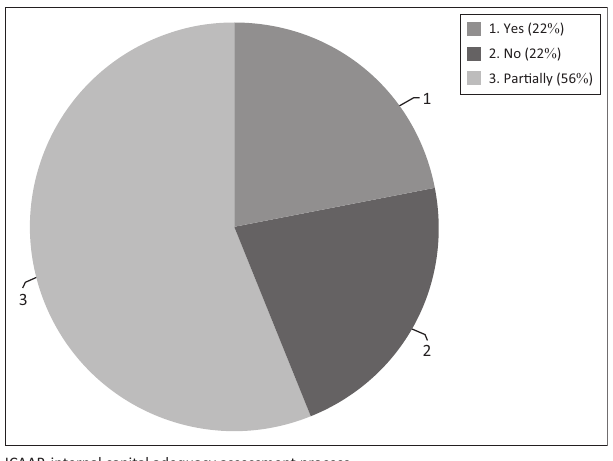
FIGURE 3: The extent of the implementation of the internal capital adequacy assessment process by participants of the interest groups.